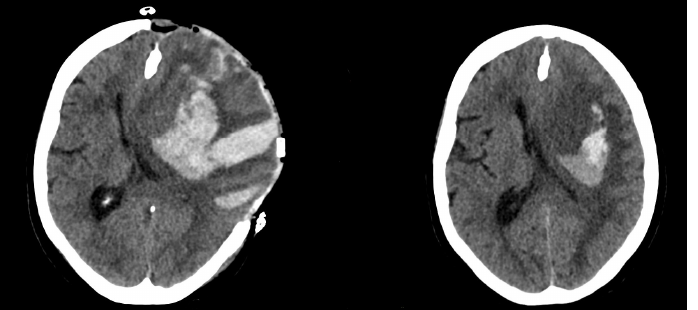
Figure 1. Postoperative ( left )/Preoperative ( right ) CT scan of a patient with hematoma expansion.